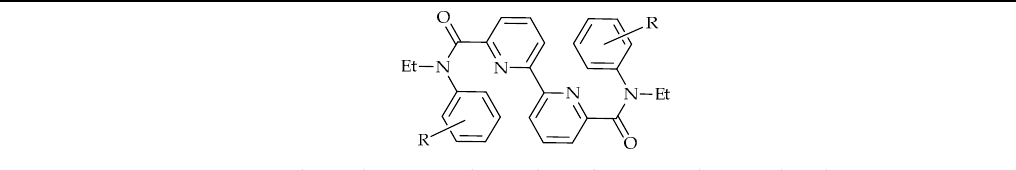
Figure 1 . Molecular structure of 2a showing the atom numbering scheme. Displacements ellipsoids are drawn at the 50% probability level and H atoms are shown as small spheres arbitrary radius. Table 2. Comparison of the several interatomic distances (Å) and angles ( ◦ ) of the primary diamide 2a Table 2 . Comparison of the several interatomic distances (Å) and angles (°) of the primary diamide with secondary diamide analogs. 2a with secondary diamide